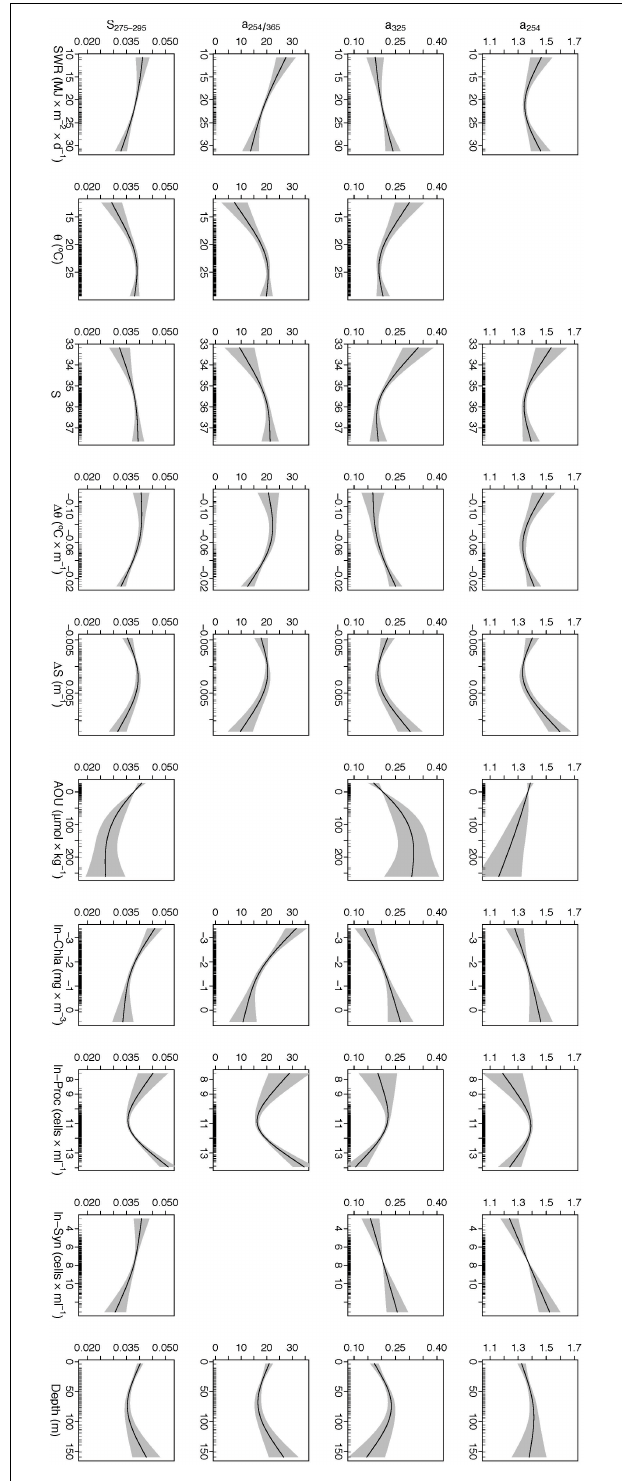
FIGURE 10 | Partial plots derived from GAMs showing the additive effects of the physical, chemical and biological factors on the optical variables. Black lines represent the smoothing functions and the gray shaded areas represent 95% point-wise confidence intervals. Rugs (ticks) on x -axis indicate the distribution of the